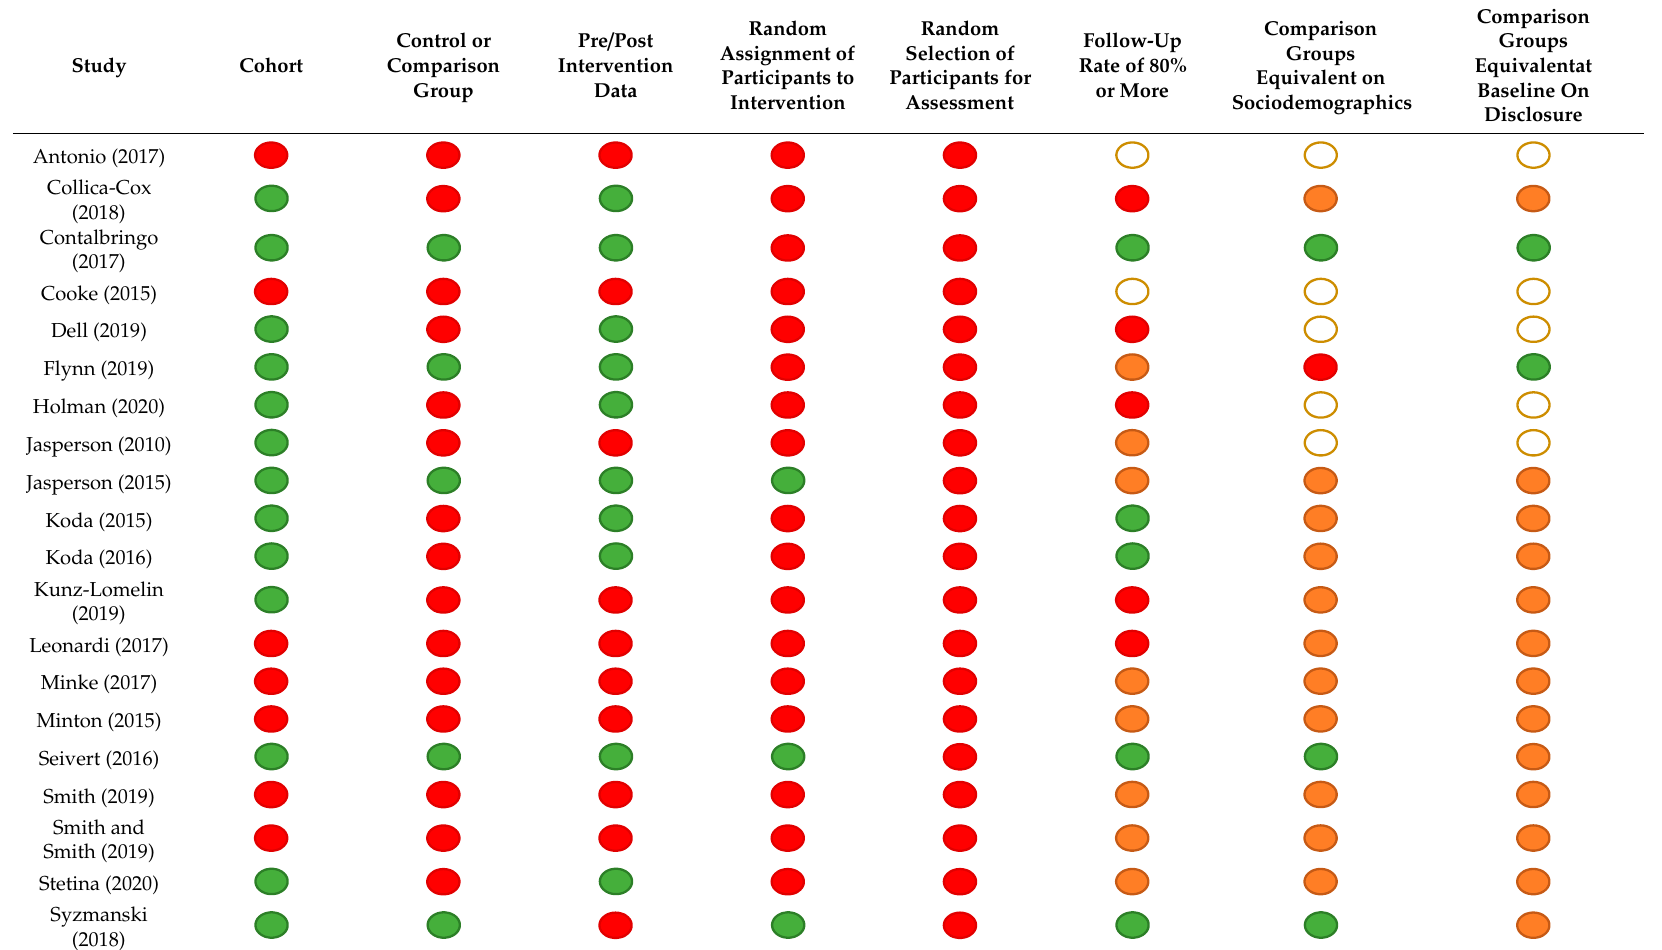
Table 1. Risk of bias of randomized and non-randomized controlled trial using the Evidence Project risk-of-bias tool.